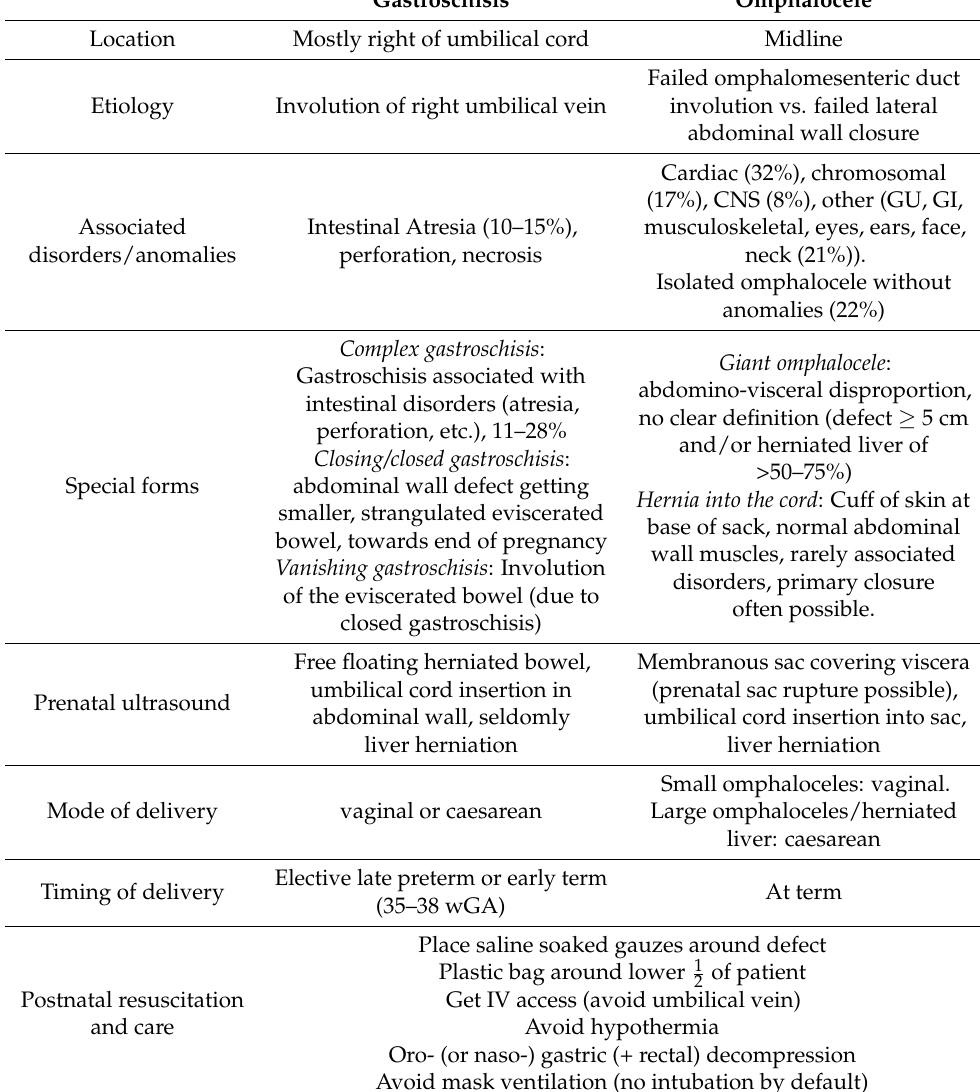
Table 1. Abdominal wall